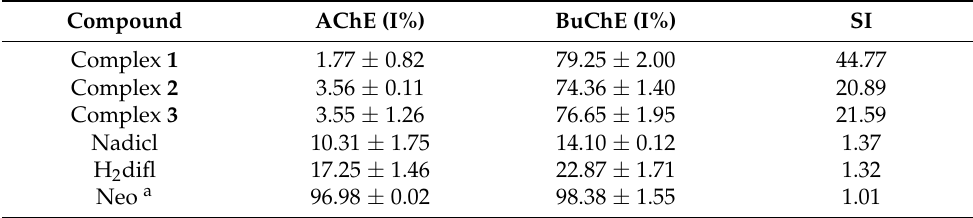
Table 5. Inhibition rate (%) of cholinesterases AChE and BuChE at 10 − 3 M of the compounds and selectivity index (SI = I BuChE /I AChE ). Neostigmine methyl sulfate is the reference compound.